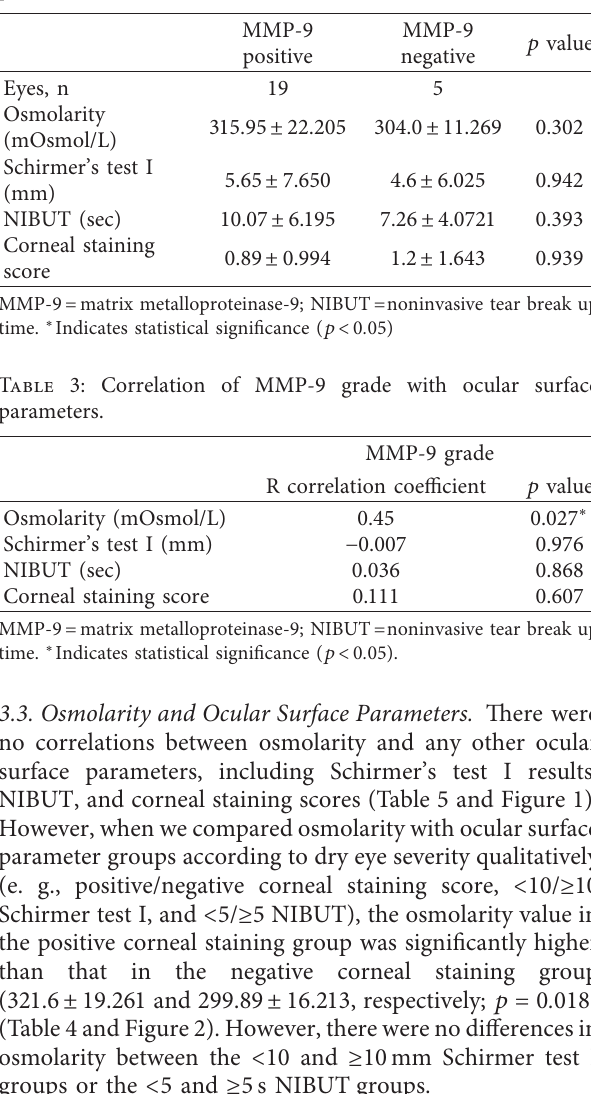
Table 2: Qualitative evaluation of MMP-9 with ocular surface parameters.